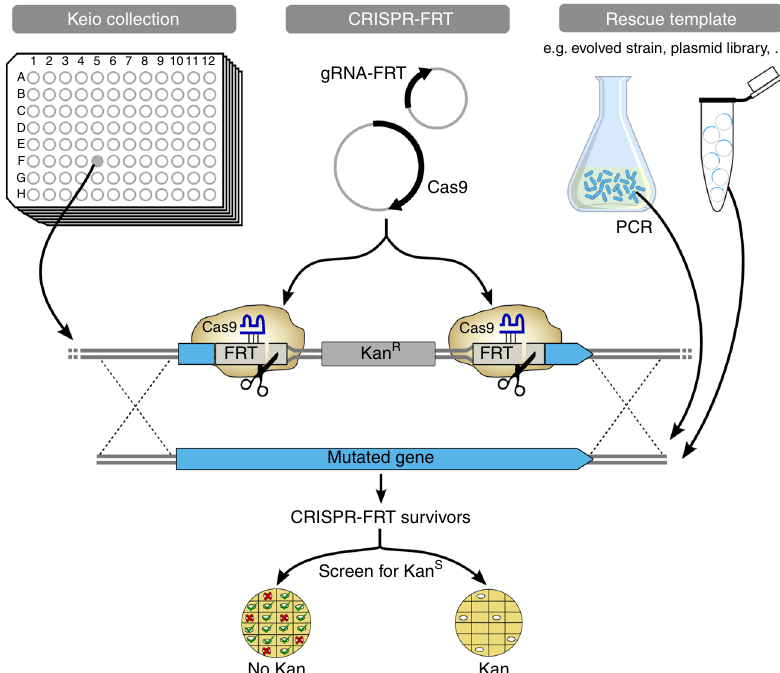
Fig. 1 Overview of the CRISPR-FRT protocol. CRISPR-FRT makes use of the arrayed collection of Keio knockout mutants having a FRT- fl anked kanamycin- resistance (Kan R ) cassette replacing each non-essential E. coli gene. CRISPR-FRT includes a gRNA-FRT that directs the Cas9 nuclease to bind and cut the two FRT sites. A convenient rescue template (e.g., a mutated gene from an evolved E. coli strain ampli fi ed by PCR, a plasmid-encoded gene variant, etc) recombines (dashed lines) over the homologous regions fl anking the Kan R cassette. Survivors are screened to separate Kan R false positives (red X) from the kanamycin sensitive (Kan S ) true positives (green check) that replaced Kan R cassette with the mutated